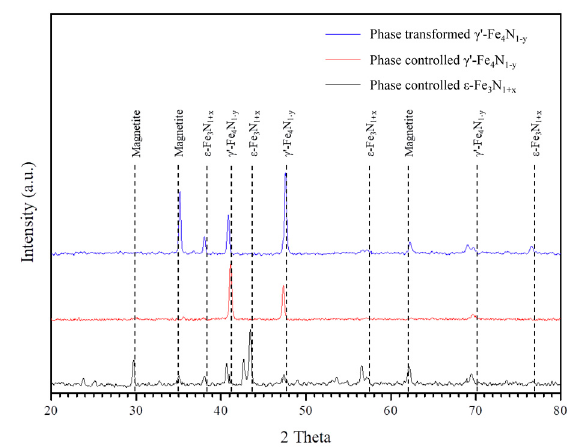
Figure 5. The XRD patterns for Gas-nitrided pure iron with 1.4, 0.38 and 1st stage: 1.4 and 2nd stage: 0.38 of nitriding potential at 570 °C.